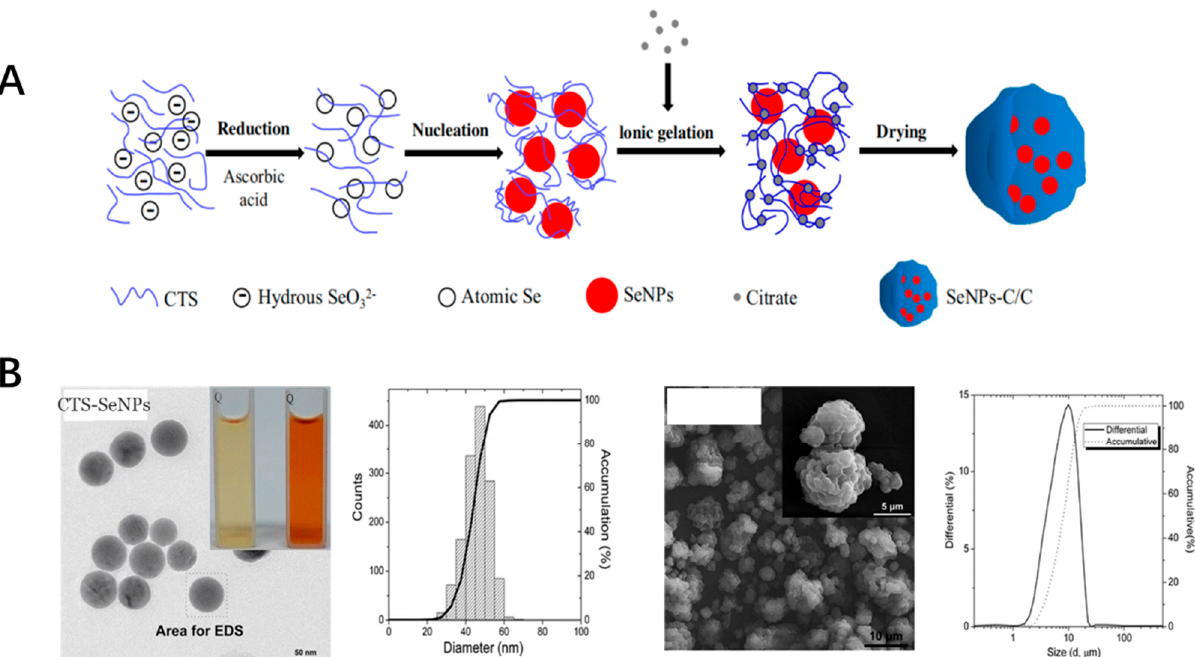
Figure 4. ( A ) The preparation process of SeNPs-C/C. ( B ) The SEM image and distribution of CTS- SeNPs as well as SeNPs-C/C.) [126].